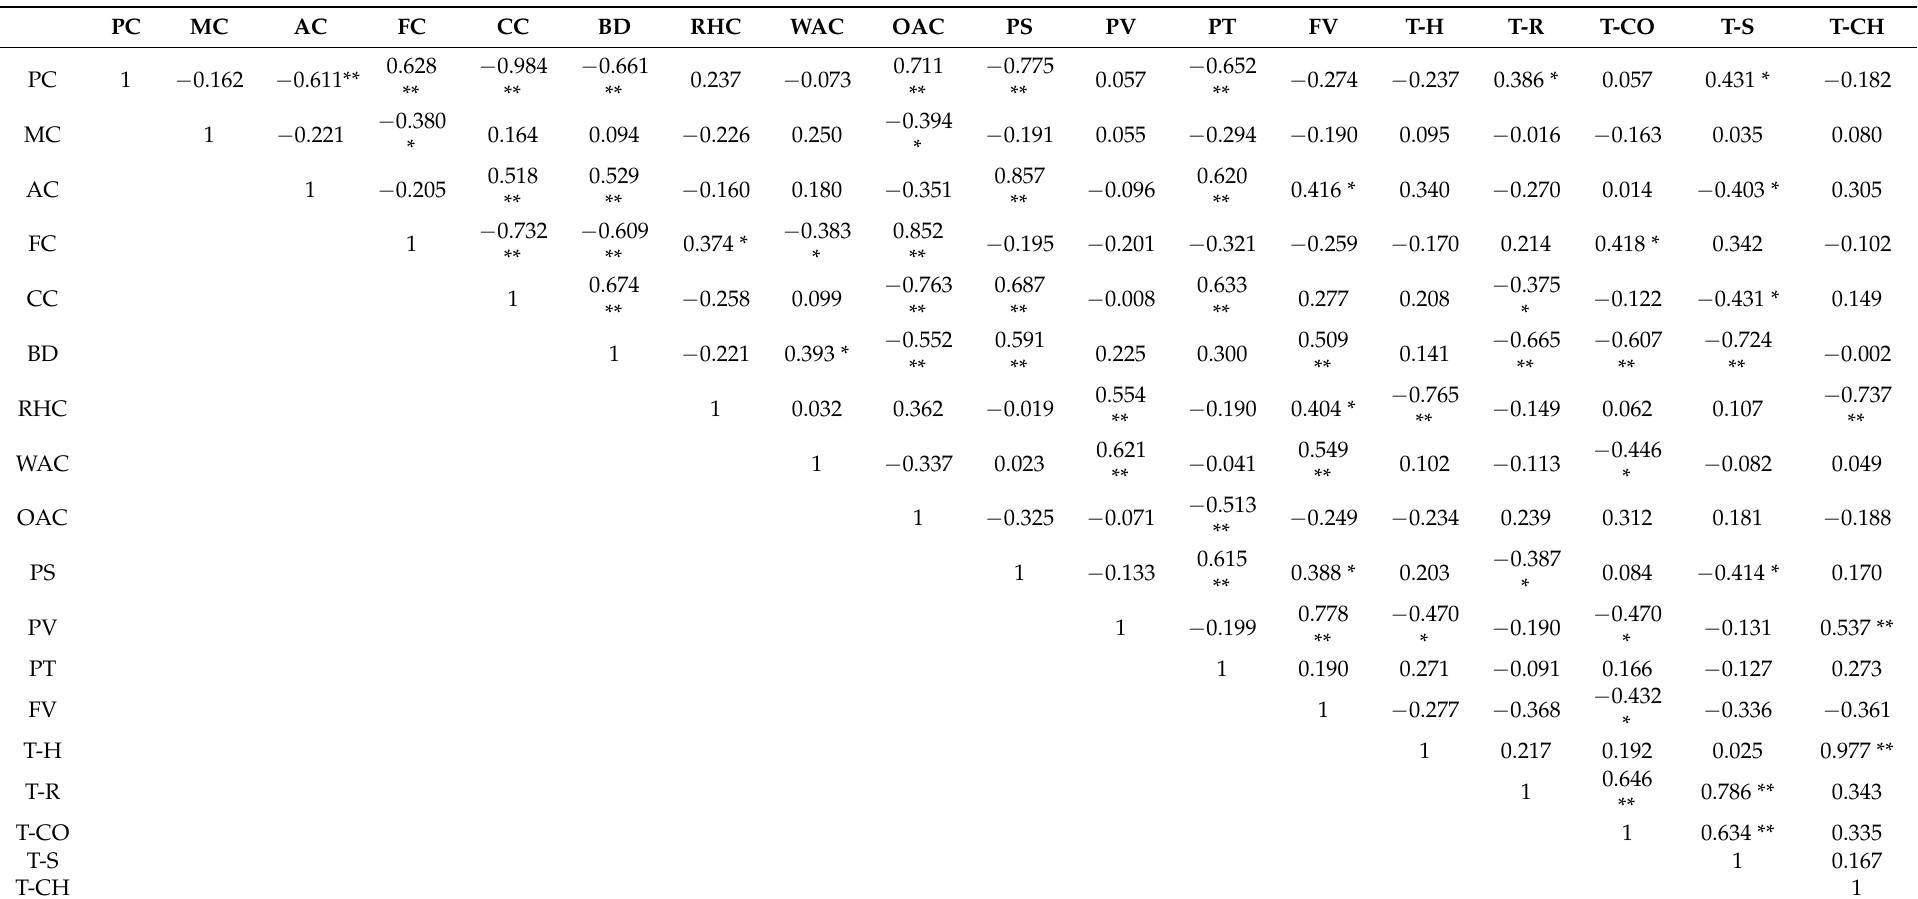
Table 2. Pearson correlation coefficients ® for the relationships between properties of TVPs and TVP-based